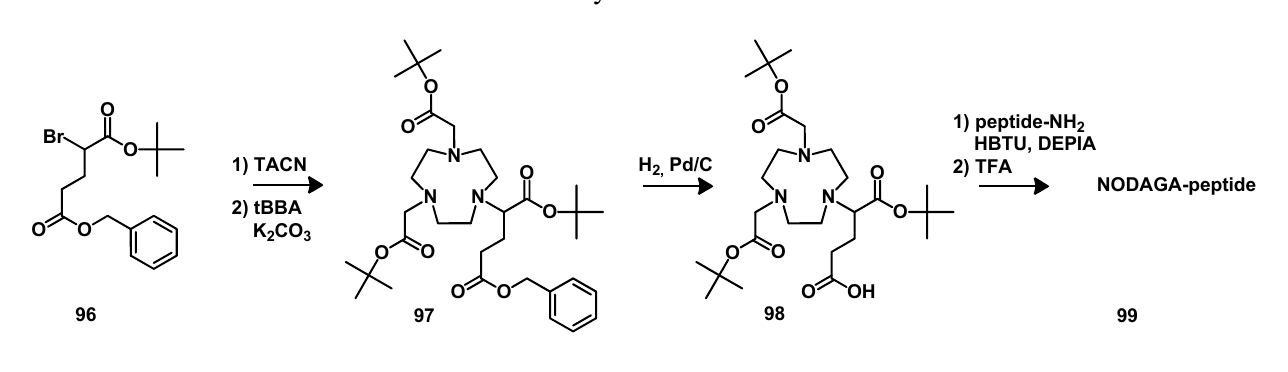
Scheme 10. Synthesis of